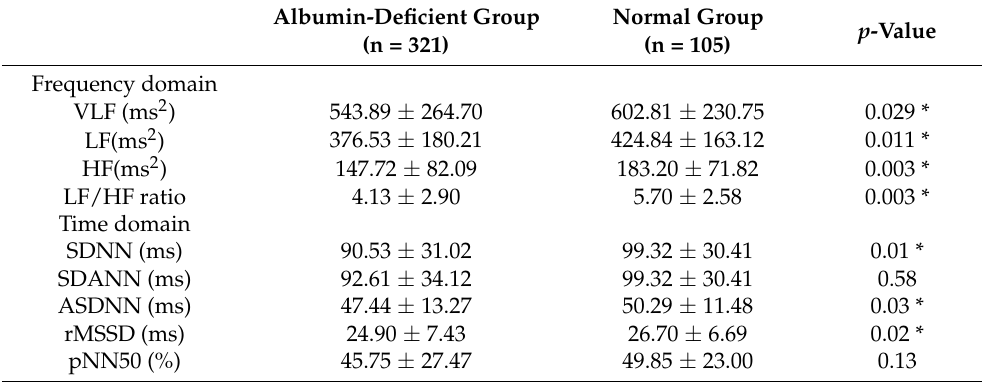
Table 2. Comparison of the HRV parameters among subgroups categorized by serum albumin level. Albumin-Deficient